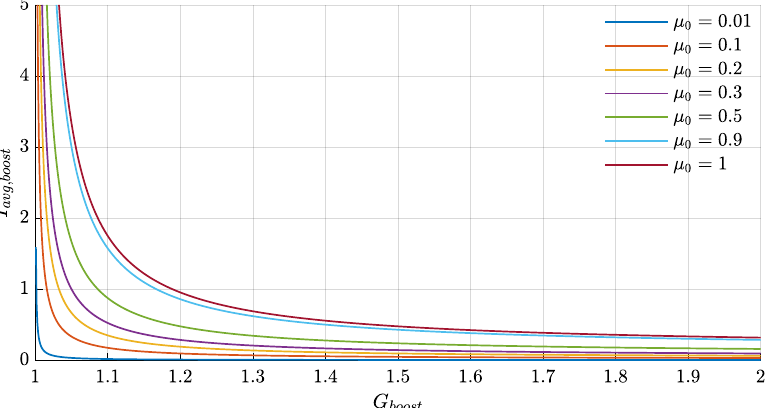
Figure 10. Output current as a function of voltage gain; the switching frequency is a